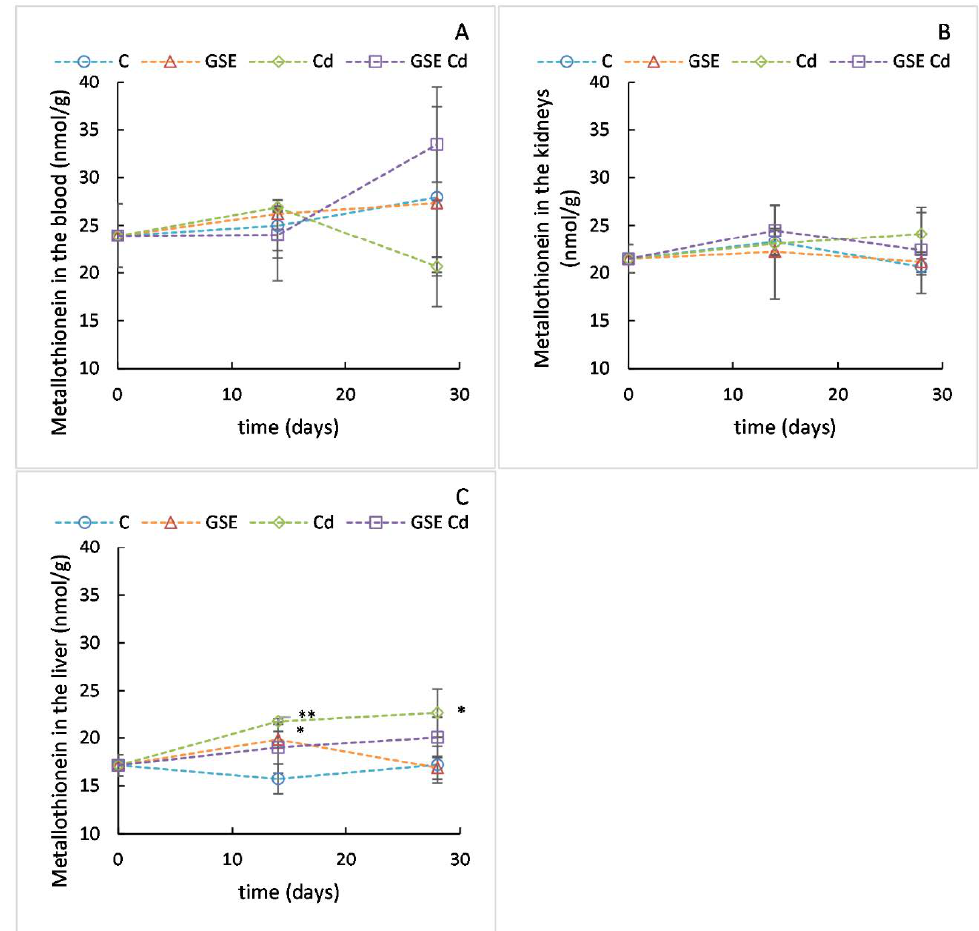
Figure 6. MT content values in blood ( A ), kidneys ( B ), and liver ( C ) for the control variant (blue line with circles), the variant with GSE addition (orange line with triangles), the variant with Cd addition (green line with diamonds), and the variant with both GSE and Cd addition (violet line with squares) on days 0, 14, and 28 of monitoring. Data are presented as means ± sd from three replicates. Data were analyzed by one-way ANOVA (each time point separately) and differences from control are marked: * indicates p ≤ 0.05, ** indicates p ≤